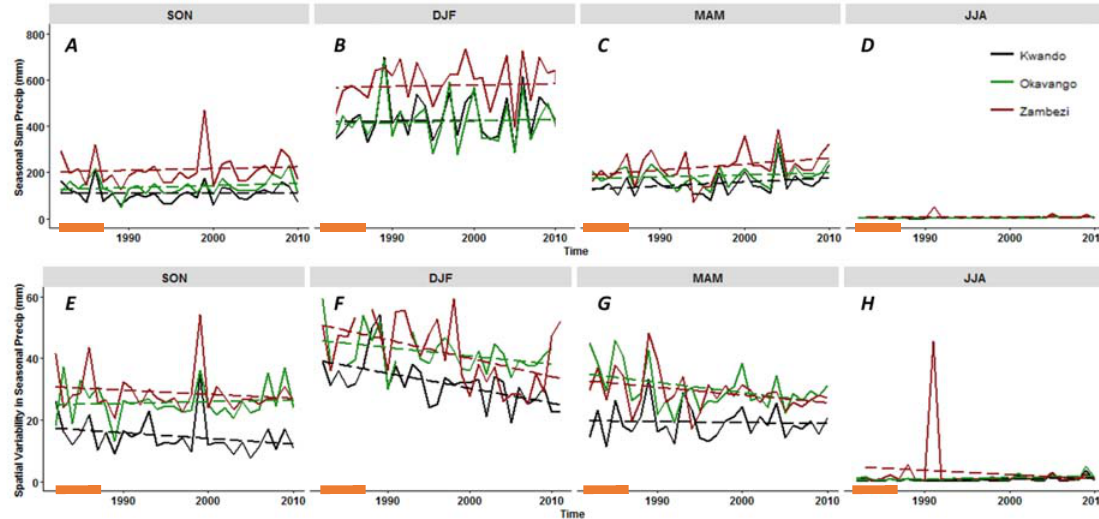
Figure 2. Seasonal (September, October, November = SON; December, January, February = DJF; March, April, May = MAM; June, July, August = JJA) total precipitation ( A – D ) and standard deviation ( E – H ) in millimeters across the Okavango, Kwando, and Zambezi from 1982–2010. The thick orange line at the bottom of each figure represents the seasonal baseline period used for the persistence analysis.